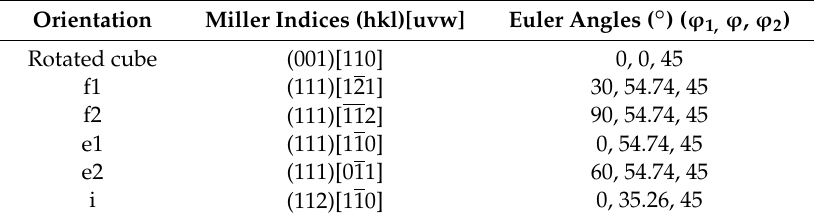
Table 2. Ideal deformation rolling texture components of BCC metals and alloys where (hkl)[uvw] represents rolling plane and rolling direction respectively.